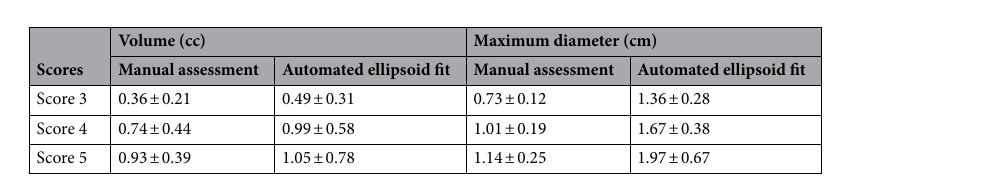
Figure 1. Ellipsoid fitting by 3D reconstruction from ROIs of diffusion-weighted MR images for different PI-RADS v2.1 scores, ( a ) Score 3, ( b ) Score 4 and ( c ) Score 5. The red contour in slices indicates the lesions. ROI Region of interest.